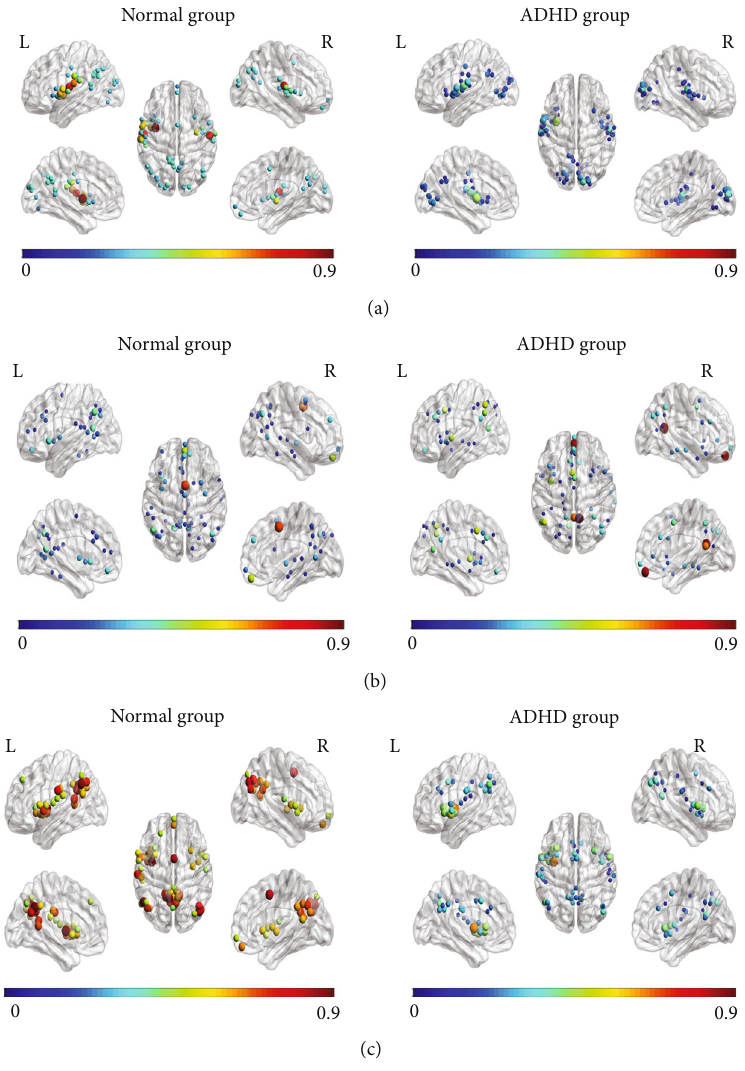
Figure 3: The top 50 node distributions with the highest network node properties of the two groups: (a) the top 50 node distributions with the highest node degrees of the two groups; (b) the top 50 node distributions with the highest node betweenness centrality of the two groups; (c) the top 50 node distributions with the highest global e ffi ciency of the two groups; the left was the normal group, and the right was the ADHD group; the color and node size represented the size of the network